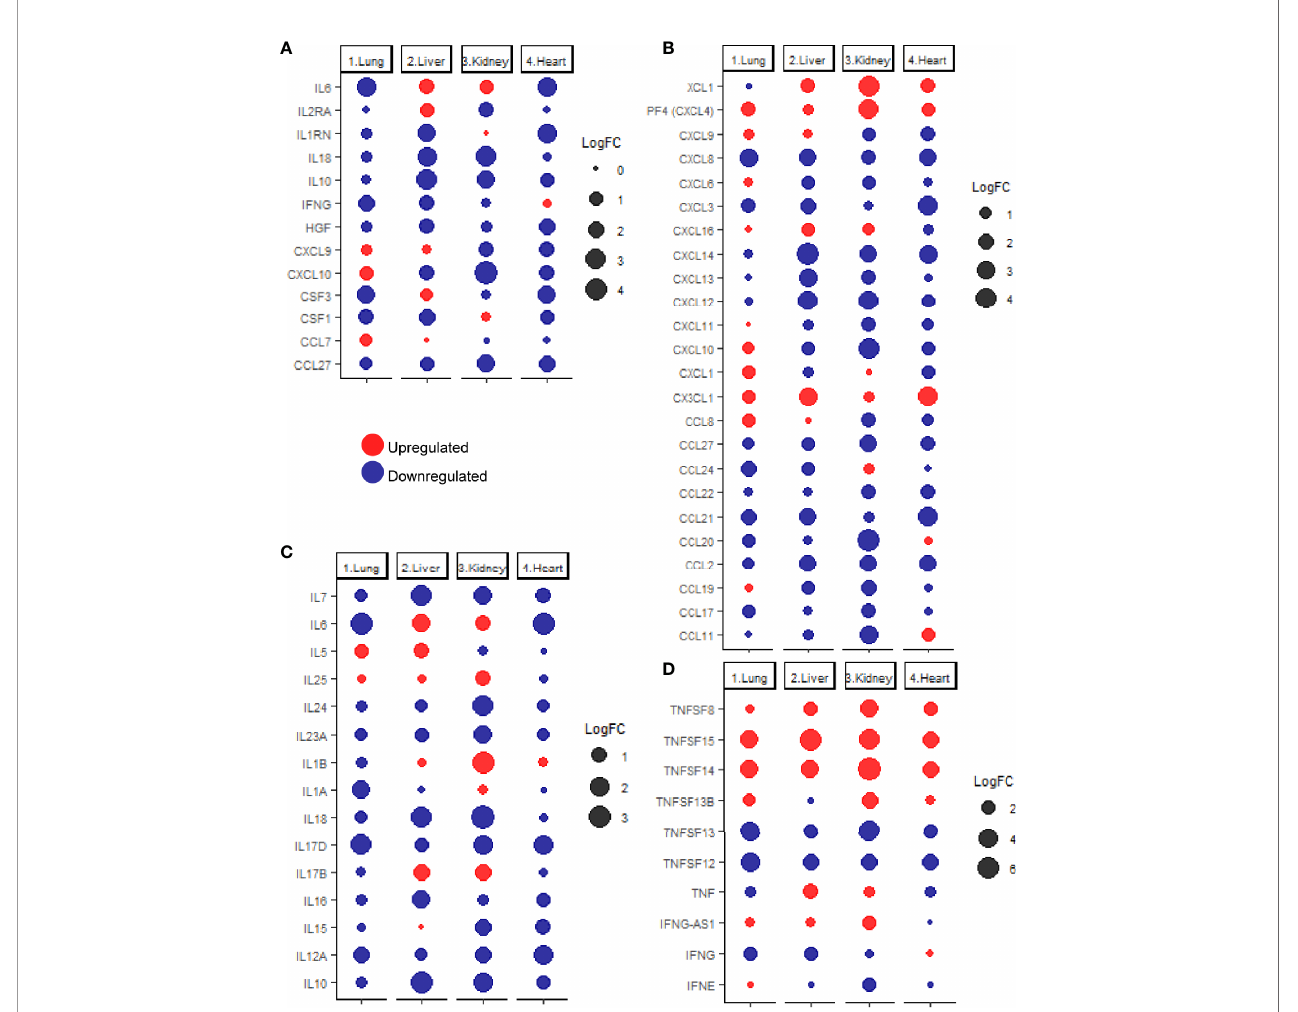
FIGURE 2 | (A) dotplot representation of the expression fold change of cytokines contributing to the cytokine storm in response to SARS-CoV-2 infection in lung, liver, kidney, and heart tissues. Dotplot representation of the differentially expressed (B) chemokines, (C) interleukins, (D) interferons and tumor necrosis factor family members in lung, liver, kidney, and heart tissues infected with